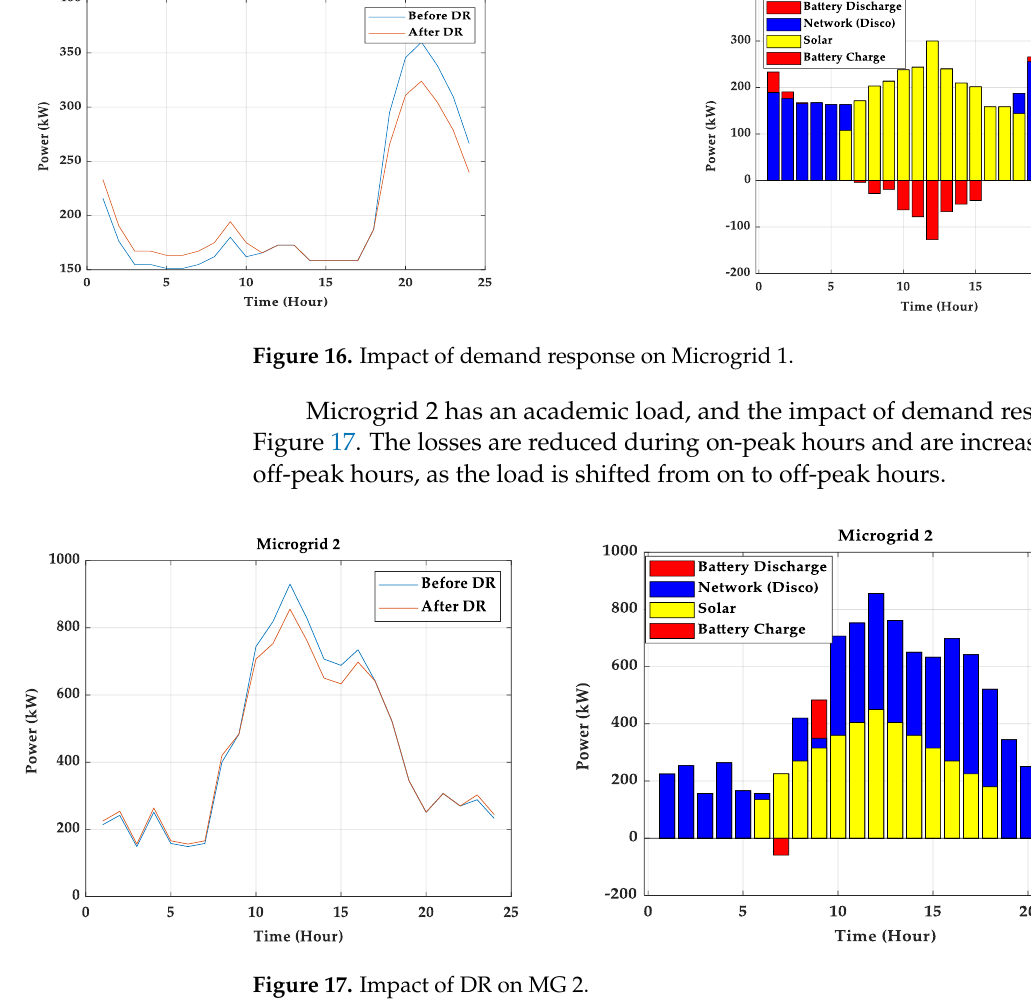
Figure 17. Impact of DR on MG 2.